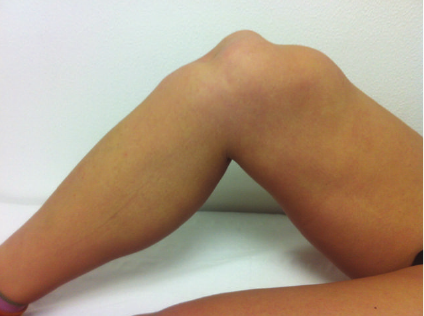
Figure 1: Lack of the normal anatomy of the right knee. The femoral condyles can be palpated.